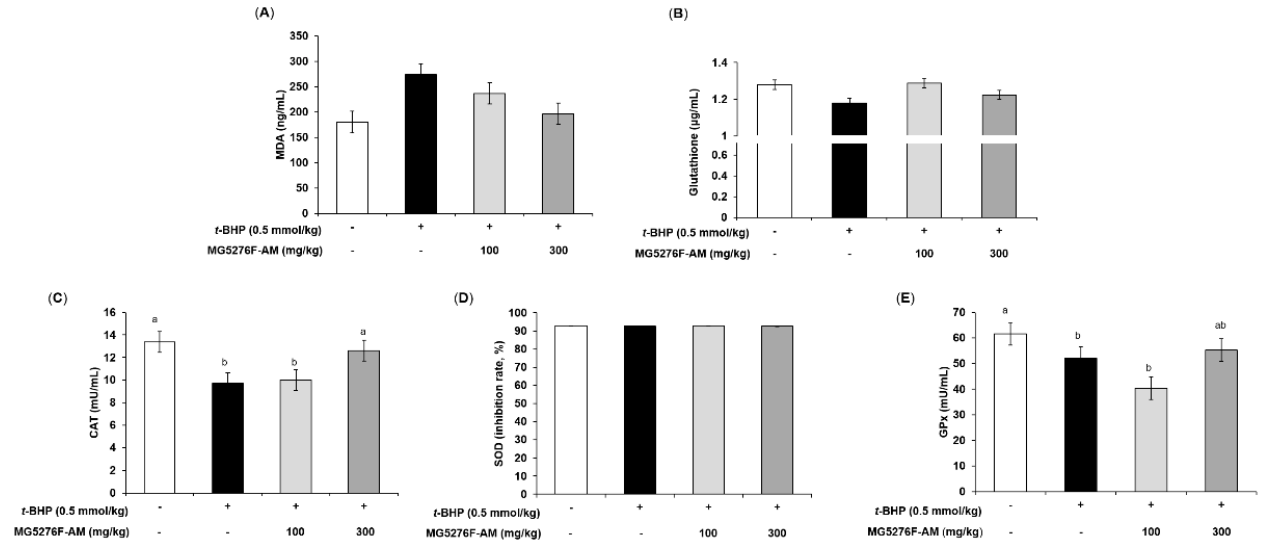
Figure 5. Effect of MG5276F-(100 and 300 mg/kg) on ( A ) MDA, ( B ) glutathione levels, ( C ) CAT, ( D ) SOD, and ( E ) GPx in t -BHP injected mice. Values are presented as mean ± SEM ( n = 7). Means with the different letters indicate significantly differences determined by Duncan’s multiple range test ( p < 0.05). MG5276F-AM, A. membranaceus fermented with L. plantarum MG5276.